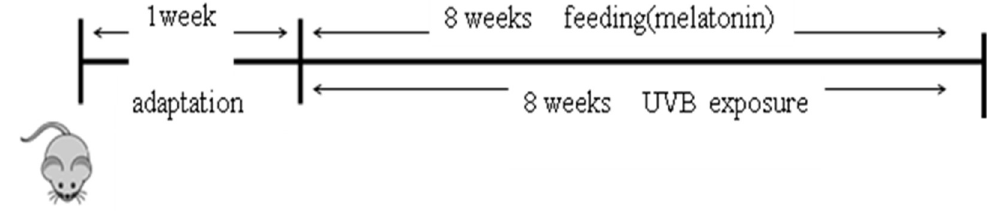
Figure 6. UVB irradiation schedule for SKH-1 hairless mice.